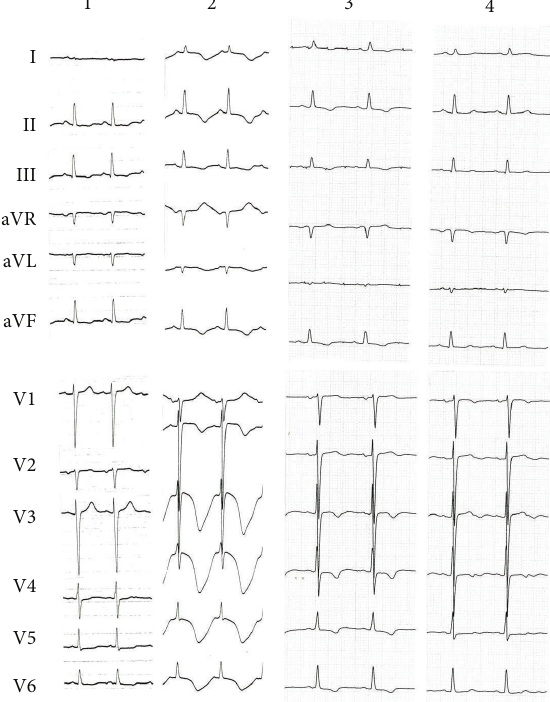
Figure3:Case1.Electrocardiographicchanges,atadmission(1),day 2 (2), day 20 (3), and day 62